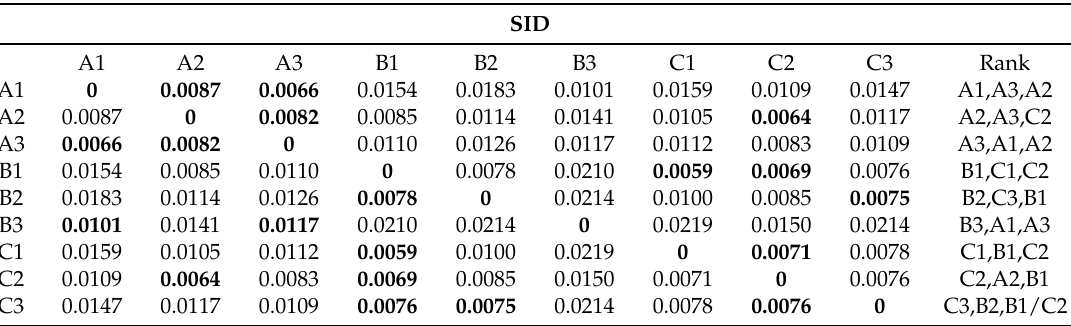
Table 3. The performance of SID for the AVIRIS dataset.